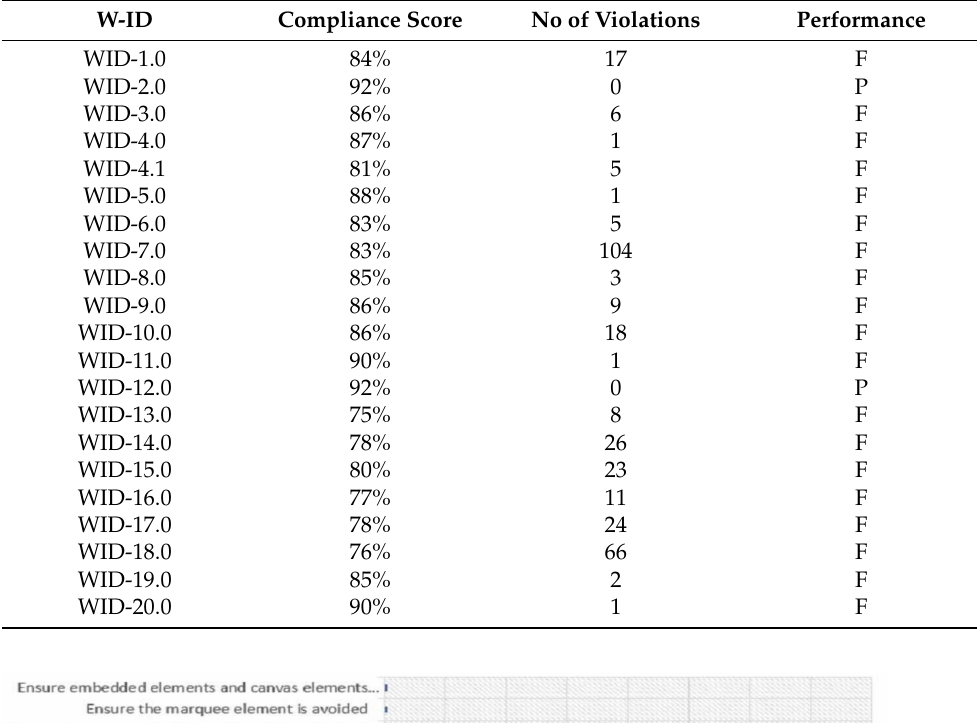
Table 8. WEB accessibility tool result considering number of violations.